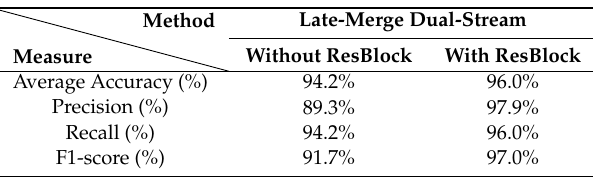
Table A4. Performance of